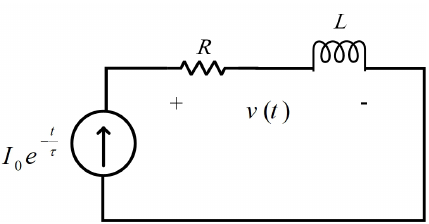
Figure 8. mimic circuit for DDC elimination from the FC